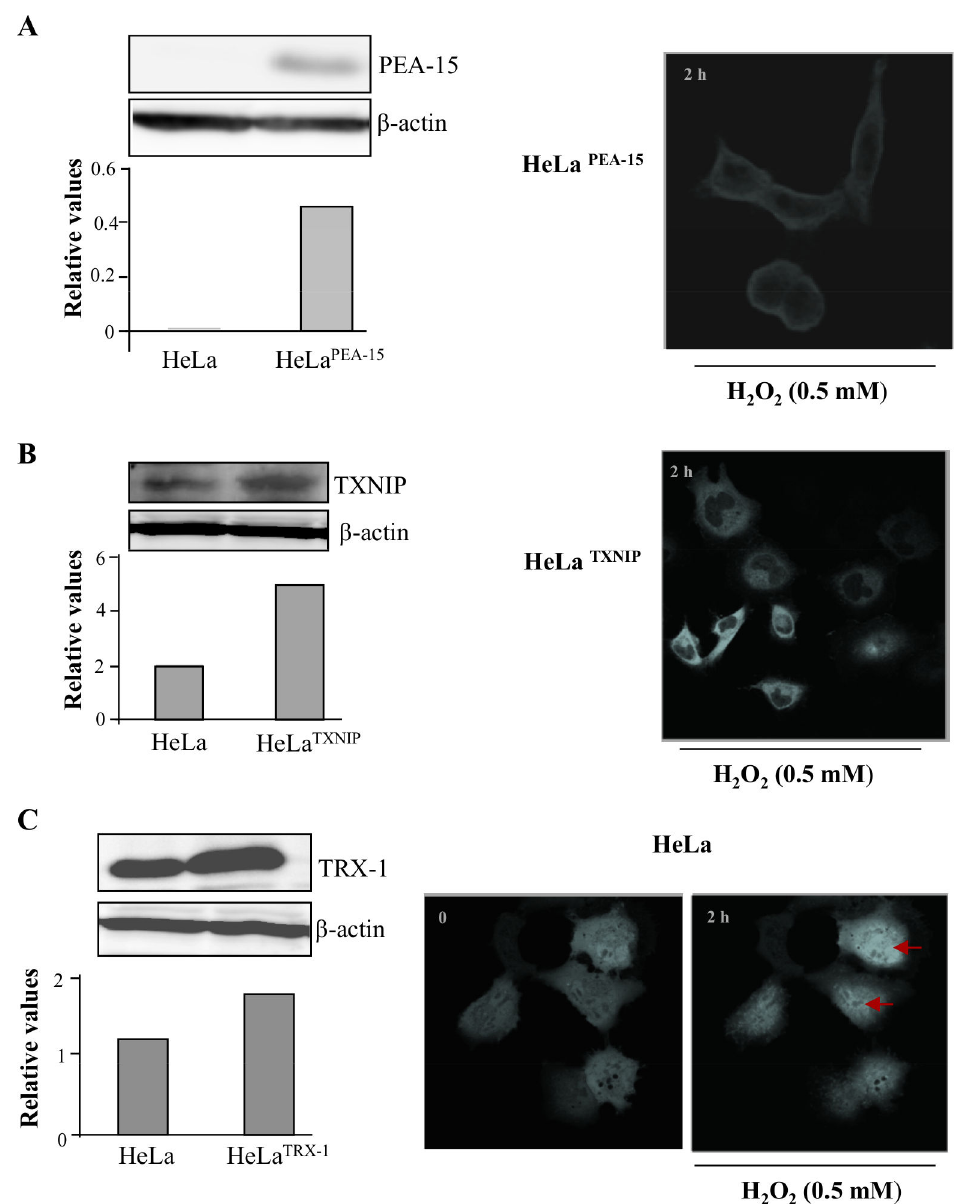
Figure 8. Determination of sub-cellular compartmentalization of TRX-1 in HeLa cells transiently over-expressing PEA-15; TXNIP; TRX-1 and exposed to 0.5 mM H O . HeLa wild-type cells were seeded in complete medium and 24 h later were 2 2 transiently transfected with the following plasmids pcDNA3_PEA-15, pcDNA3_TXNIP, and pEGFP-C1_TRX-1. After 16 h, transiently transfected cultures were divided to perform either western blot analysis, to confirm over expression of designated inserts, or to perform immunofluorescence-based analysis to determine TRX-1 sub cellular localization after exposure to 0.5 mM H O . ( A ) HeLa cells transfected with pcDNA3_PEA-15. Left panel: western blot analysis of PEA-15 expression. Right panel: 2 2 Immunofluorescence image of TRX-1 cellular location. ( B ) HeLa cells transfected with pcDNA3_TXNIP. Left panel: western blot analysis of TXNIP expression. Right panel: Immunofluorescence image of TRX-1 cellular location ( C ) HeLa cells transfected with pEGFP-C1_TRX-. Left panel: western blot analysis of TRX-1 expression. Right panel: Immunofluorescence image of TRX-1 cellular location. Red arrows indicate TRX-1 nuclear accumulation.